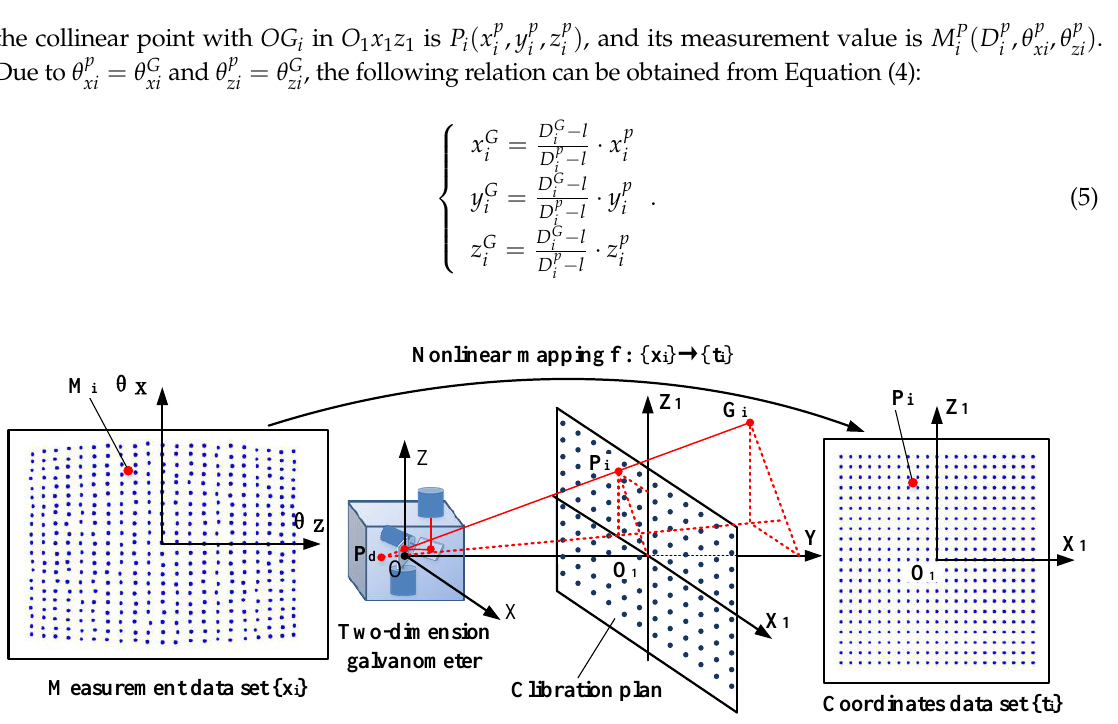
Figure 2. Principle of data-driven calibration.